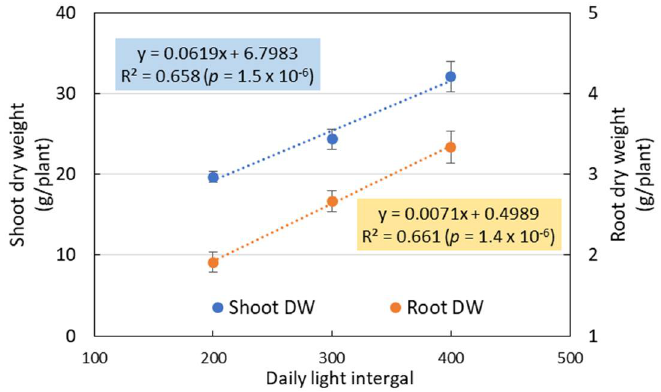
Figure 5. Relationship between the biomass (shoot and root dry weight) of the nasturtium plant (y) and the daily light integral (DLI; in terms of the light intensity) (x) at the last stage of plant growth (21 DAT). Each dot shows the mean ± SE ( n = 8), and the R 2 and the probability of the regression estimation are estimated using the raw data ( n = 24).